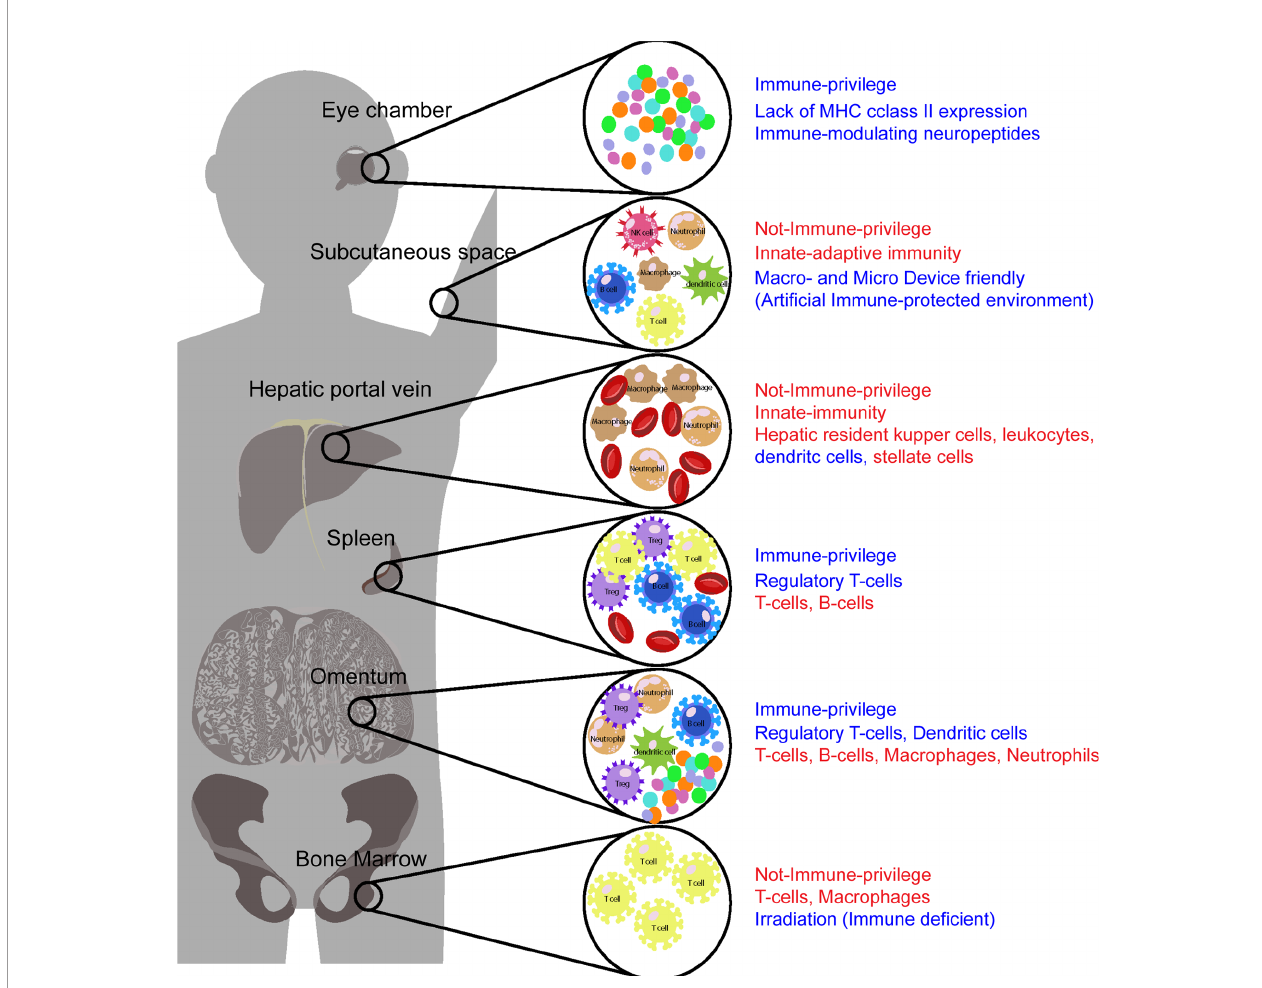
FIGURE 2 | Major immune components in each site affecting success of transplantation. Each islet transplantation sites have different microenvironment, which include immune system components that either increase or decrease of islet engraftment. Some of these sites, such as the omentum, spleen and anterior chamber of the eye, are considered immune-privileged. The presence of anti-in fl ammatory factors and regulatory T-cells that suppress expansion of effector T-cells and decreasing the effects of proin fl ammatory cytokines are key immune modulators in immune privilege sites. Other sites, such as the subcutaneous space and the bone marrow sites contain T cells and NK cells, among other immune cells that contribute to graft rejection and long-term viability of transplanted islets. Strategies must be incorporated in these sites to not only increase angiogenesis but also modulate immune responses to prevent graft rejection. The potential anti-in fl ammatory components in each site are described by blue color and the potential in fl ammatory components in each site are described by red